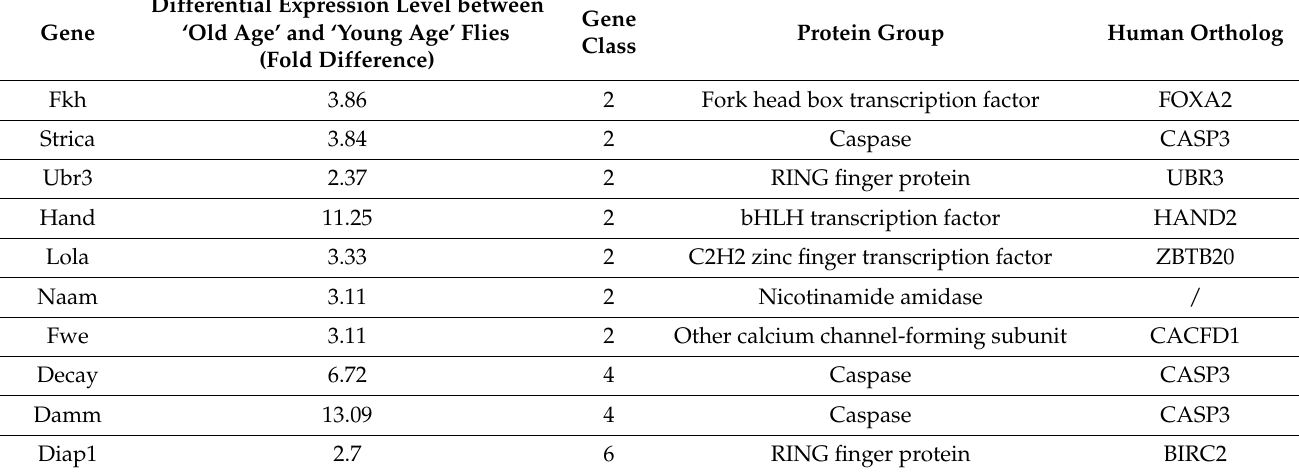
Table 3. Sample of genes that belong to the GO-term “Cell death”. Fold change shown is old age flies relative to young age flies. Differential Expression Level between Gene ‘Old Age’ and ‘Young Age’